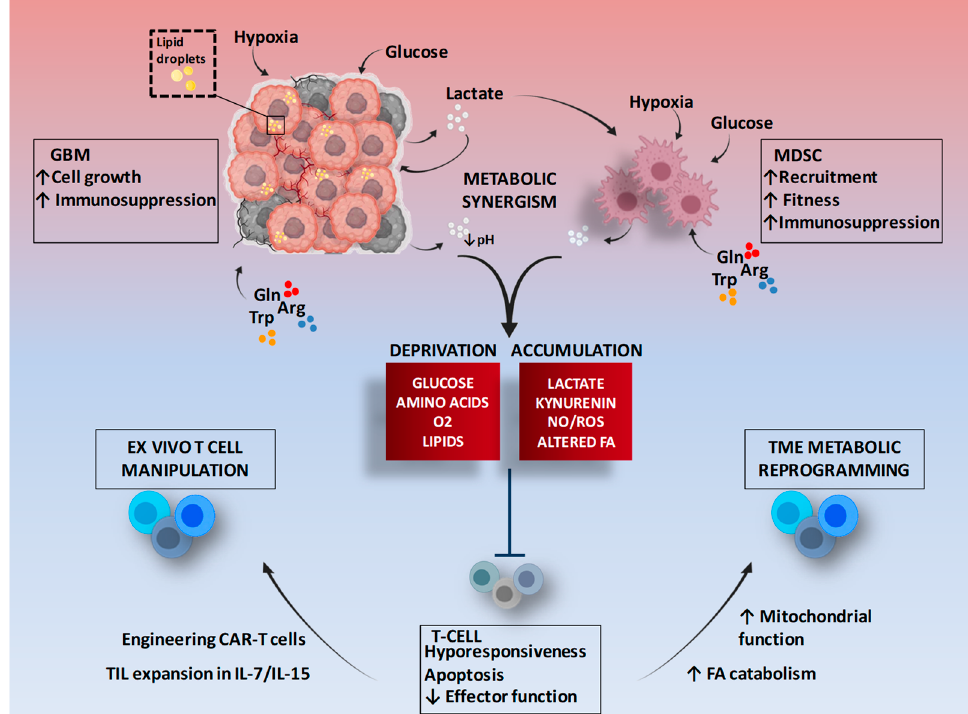
Figure 1. Metabolic symbiosis between GBM and MDSCs and therapeutic potential of T cell metabolic targeting. The figure shows as tumor cells and MDSCs, in a hypermetabolic state, interact to promote an immunosuppressive environment, and some mechanisms of modulation to improve the metabolic performance of T cells. Gln: Glutamine; Arg: Arginine; Trp: Tryptophan; TME: Tumor microenvironment; FA: Fatty acids; TIL: Tumor infiltrating lymphocytes; CAR: Chimeric antigen receptor. Figure adapted from images created with BioRender.com.